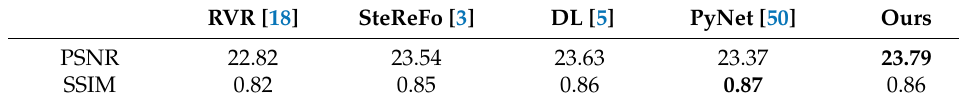
Figure 13. Some visual examples of our predicted saliency maps, depth maps, and shallow DoF im- ages. Table 7. Quantitative results of different methods on the EBB [50] dataset.